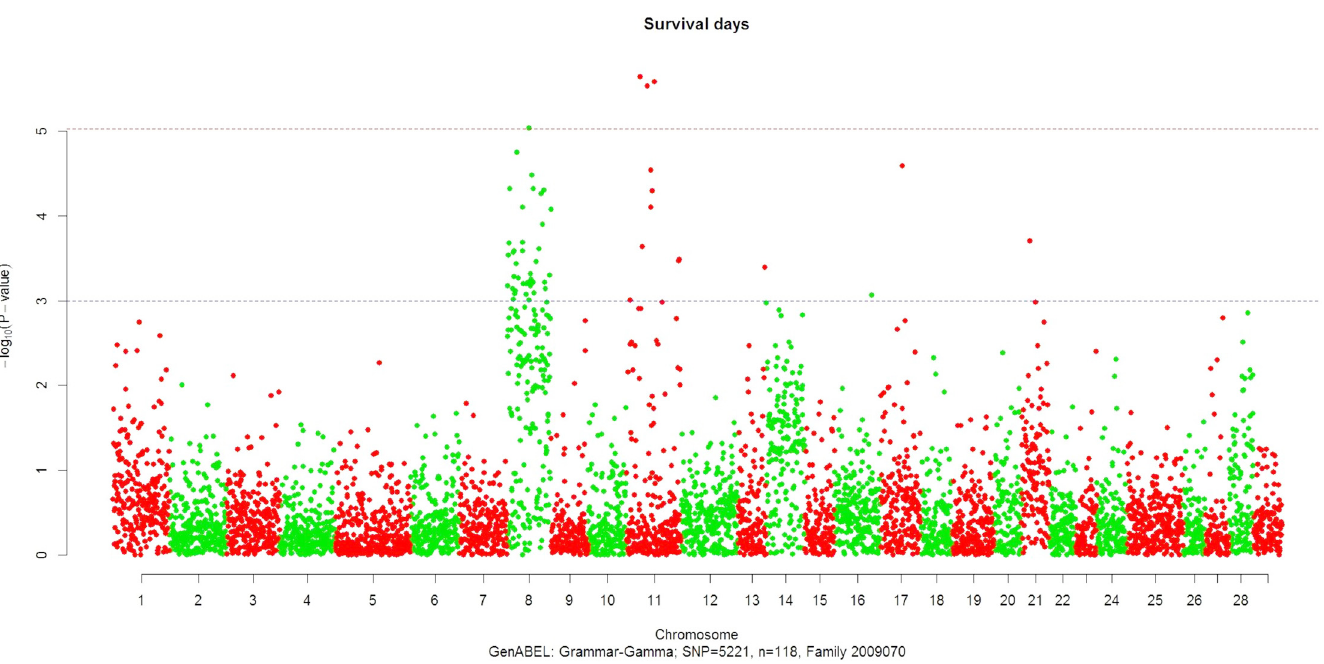
Fig 2. Results of GWAS for the survival days phenotype recorded post-infection with Flavobacterium psychrophilum in rainbow trout family